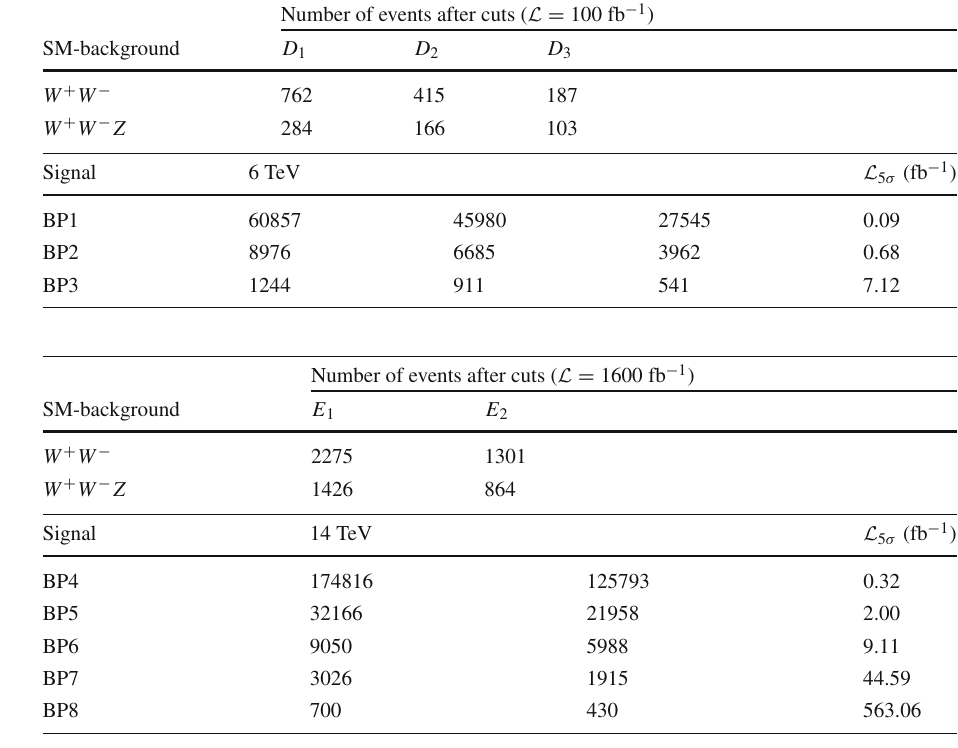
luminosity 100 fb − 1 . In the bottom half of the same table, we show the cut-flow of the signal benchmarks BP1–BP3 at √ s = 6 TeV. After incorporating all three cuts ( D 1 , D 2 , D 3 ), only 187 and 103 events survive from W + W − and W + W − Z backgrounds respectively at integrated luminosity 100 fb − 1 . While remaining signal events for BP1, BP2 and BP3 are 27545, 3962 and 541 respectively at the same luminosity.